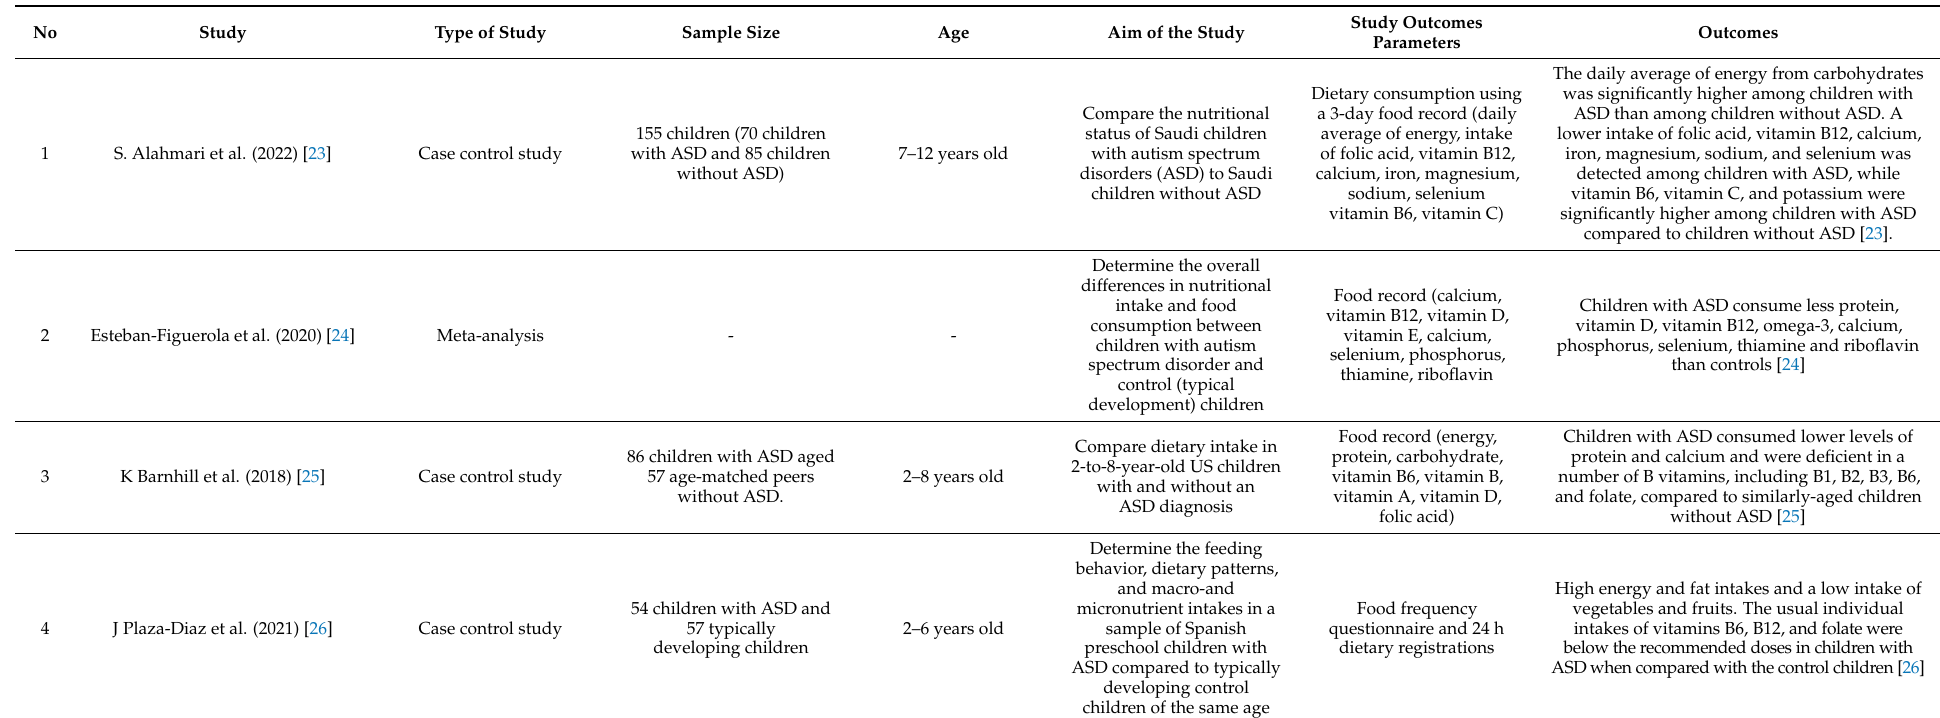
Table 1. Studies on the deficiency of B vitamins in ASD